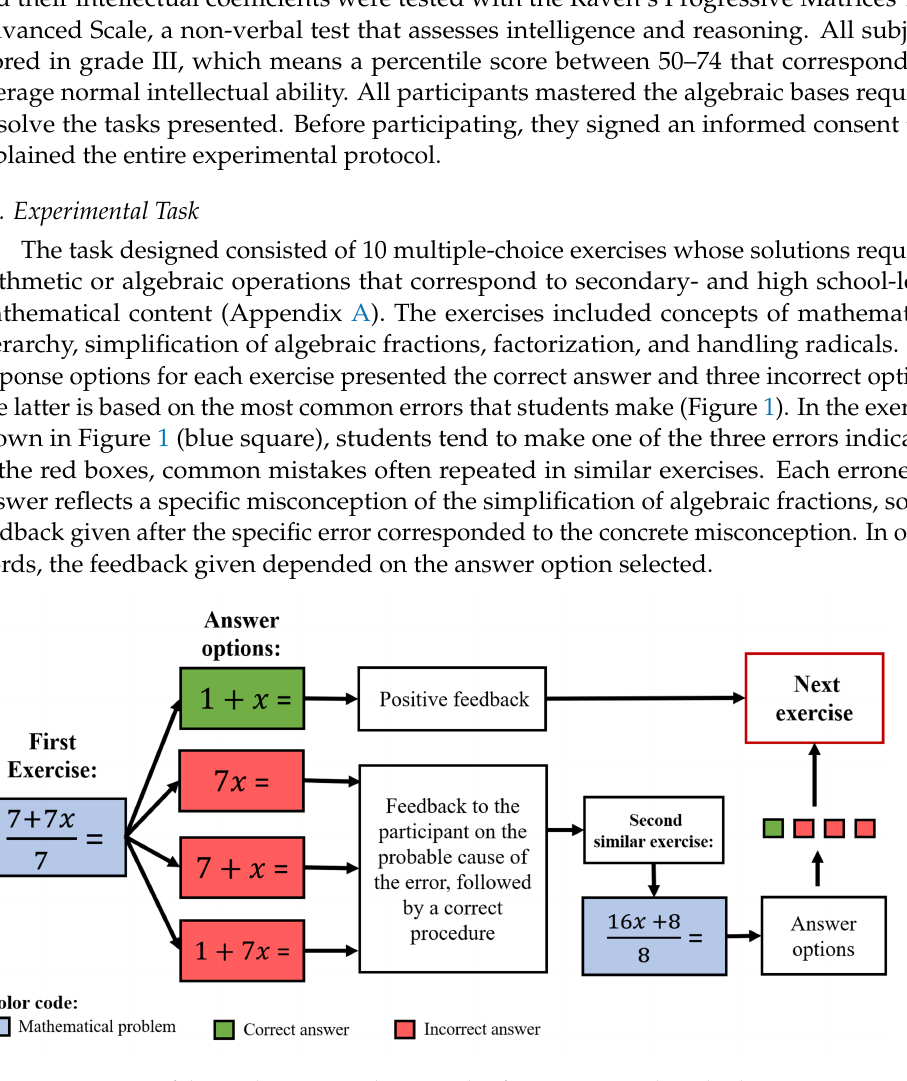
Figure 1. Structure of the mathematics task. Example of an exercise with multiple answer options and feedback. The green block represents the correct answer, while the red ones correspond to common incorrect